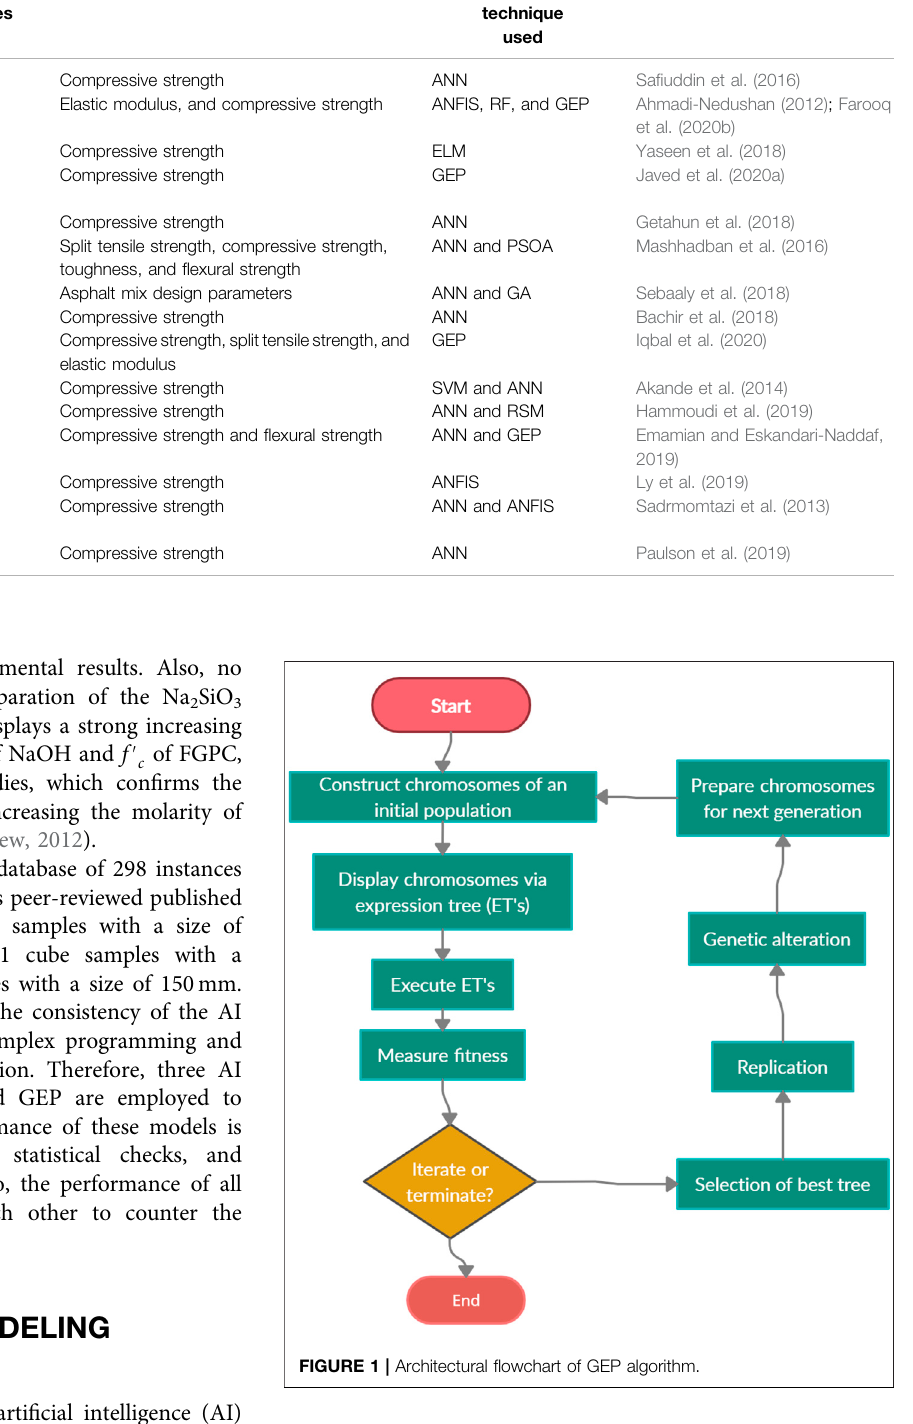
TABLE 1 | Application of arti fi cial intelligence (AI) techniques in civil engineering materials. Type of concrete